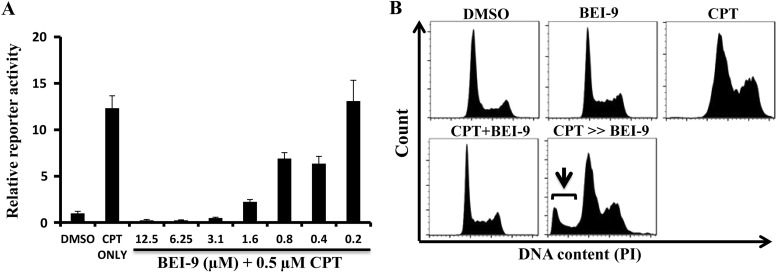
Effect of BEI-9 on induced reporter activity. (A) NF-κB activity in SW480 reporter cells was induced by treating the cells with camptothecin (CPT) (0.5 µM) for 24 h in the presence or absence of the indicated concentrations of BEI-9. Relative reporter activity, normalized to dimethyl sulfoxide (DMSO)-treated cells is shown. (B) Cell cycle profiles of parental SW480 cells exposed to DMSO, BEI-9, CPT, BEI-9 and CPT combined (CPT+BEI-9) for 24 h, or 24 h of CPT followed by 24 h of only BEI-9 (CPT>>BEI-9) are shown. The short arrow points to the sub-G1 population of cells resulting from the sequential treatment. The x-axes of histograms in B indicate propidium iodide (PI) staining intensity, representing the DNA content of cells, whereas the y-axes indicate cell counts.